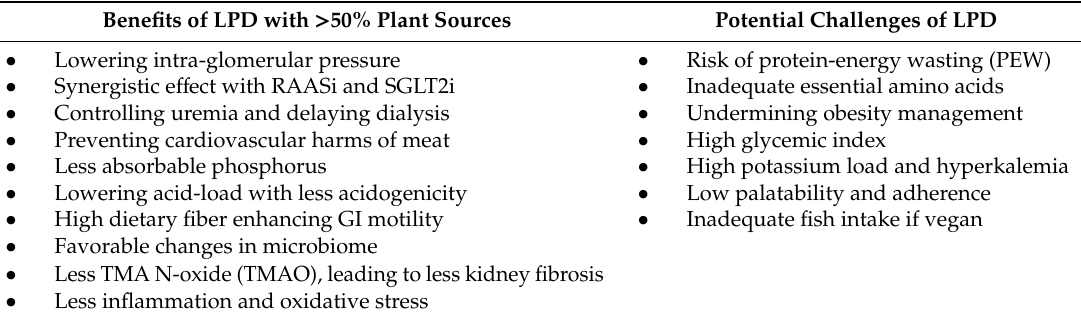
Table 3. Benefits and challenges of LPD with > 50% plant-based protein